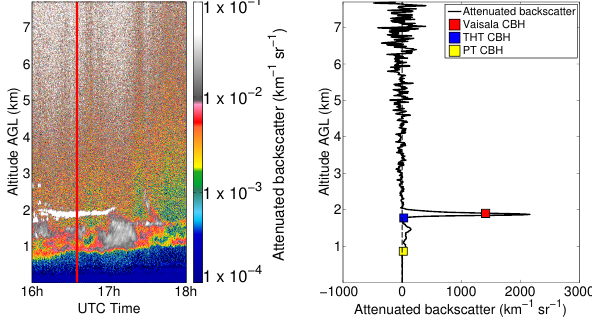
Fig. 5. A time height cross section of the attenuated backscatter coefficient (left) and a comparison between Vaisala (red), THT (blue) and PT (yellow) derived CBH in an example attenuated backscatter profile (indicated by red line in the left image) at PE on 14 March 2011 (right). Vaisala and THT report the CBH at high backscatter values. The PT algorithm is triggered at low backscatter values.